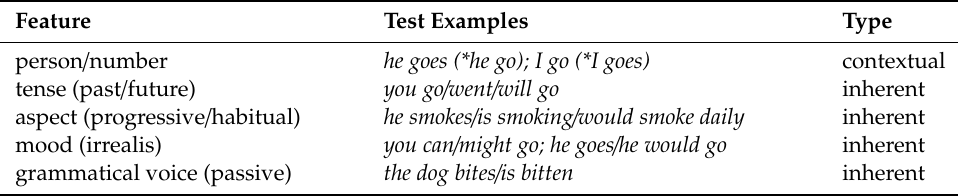
Table 2. The assignment of verbal